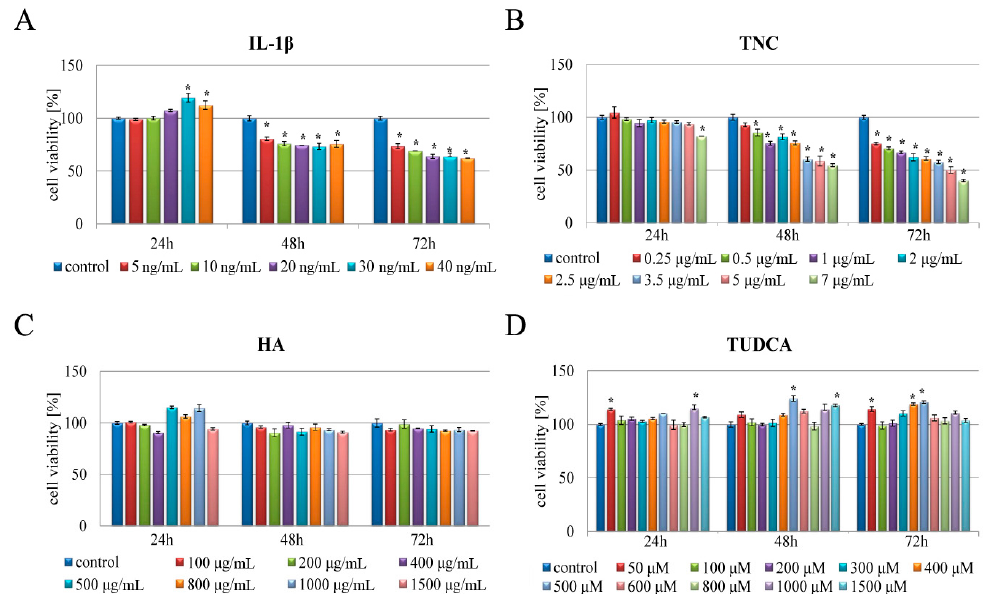
Figure 1. Effect of IL-1 β , TNC, TUDCA, and HA on the viability of NHAC-kn chondrocytes. Chondrocytes were treated for 24, 48, and 72 h with the indicated concentrations of IL-1 β ( A ), TNC ( B ), HA ( C ), and TUDCA ( D ) in normoxic conditions. The viability of chondrocytes was determined using the MTT assay. The results represent means for pooled triplicate values from three independent experiments. Significant changes are expressed relative to controls and marked with asterisks. Statistical significance was considered if * p <